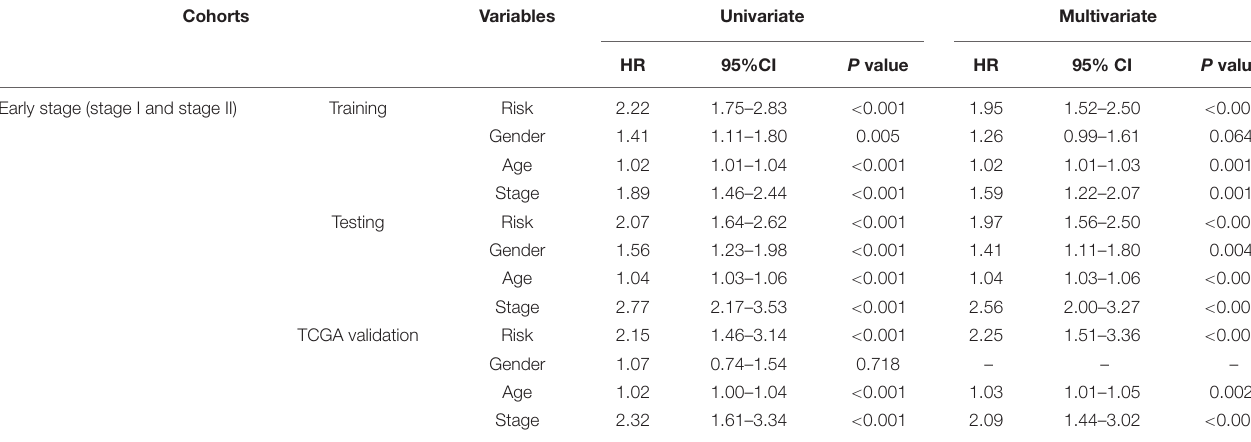
TABLE 5 | Univariate and multivariate analyses of autophagy-related gene pair index (ATGPI) and clinical characteristics in the training, testing, and The Cancer Genome Atlas (TCGA) validation data sets. Cohorts Variables Univariate Multivariate